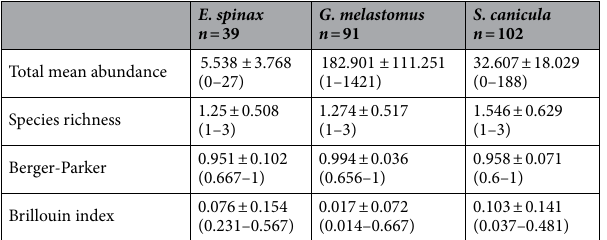
Table 3. Average values (± standard deviation) and range (values in brackets) of measured parameters of parasite infracommunities found in E. spinax , G. melastomus , and S. canicula from the Gulf of Naples.